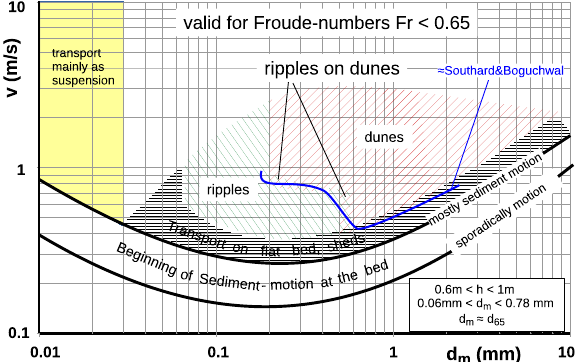
Figure 2. Bed forms as expression of the sedimentological and hydraulic parameters for the sand- water system, modified after Zanke (1976) [7]. For comparison, the limiting curve of the areas of the ripples and the dunes of Southard and Boguchwal 1990 [8] is shown in blue